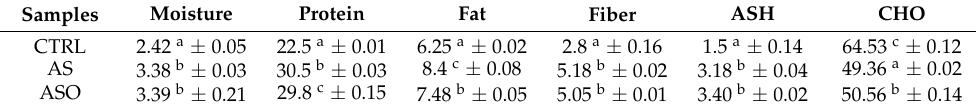
Table 2. Proximate composition (%) of the complementary food blends (dry basis). Samples Moisture Protein